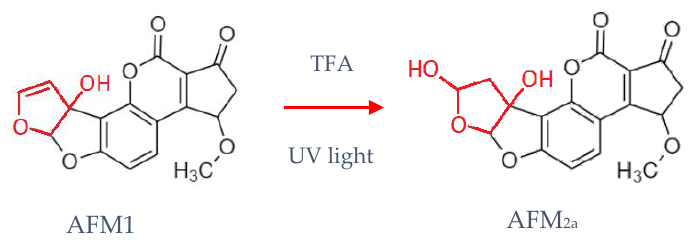
Figure 4. Reaction of AFM1 with trifluoroacetic acid (TFA) and UV light.